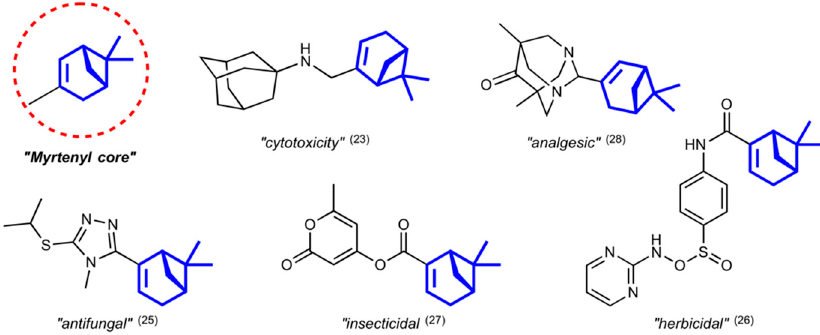
Figure 1. Relevant bioactive Myrtenal hybrid compounds and structure of Myrtenyl core.